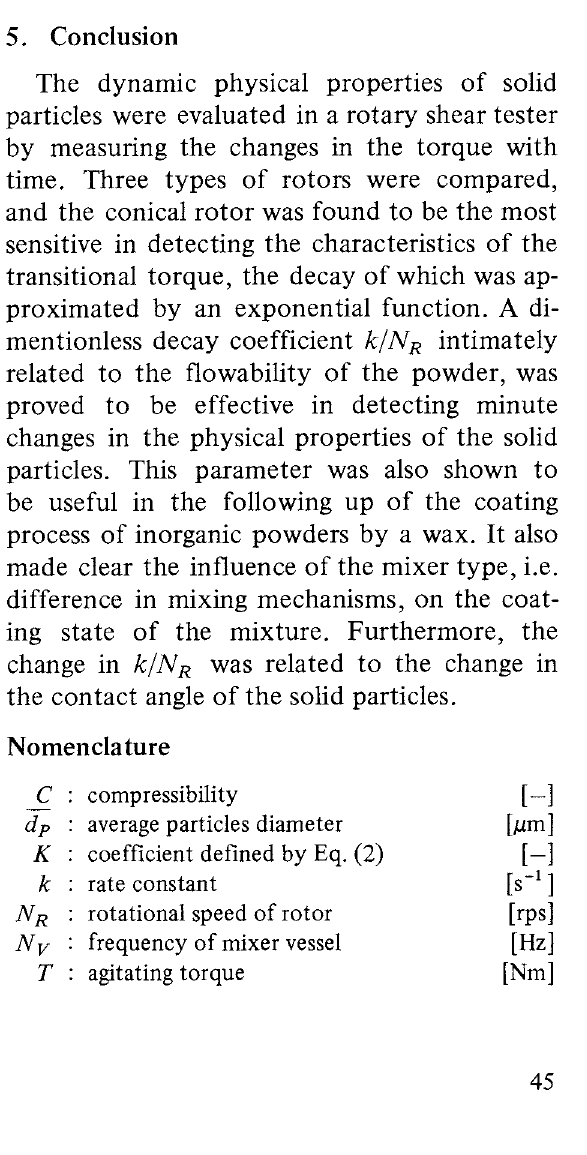
Fig. II Effect of wax quantity on the coated